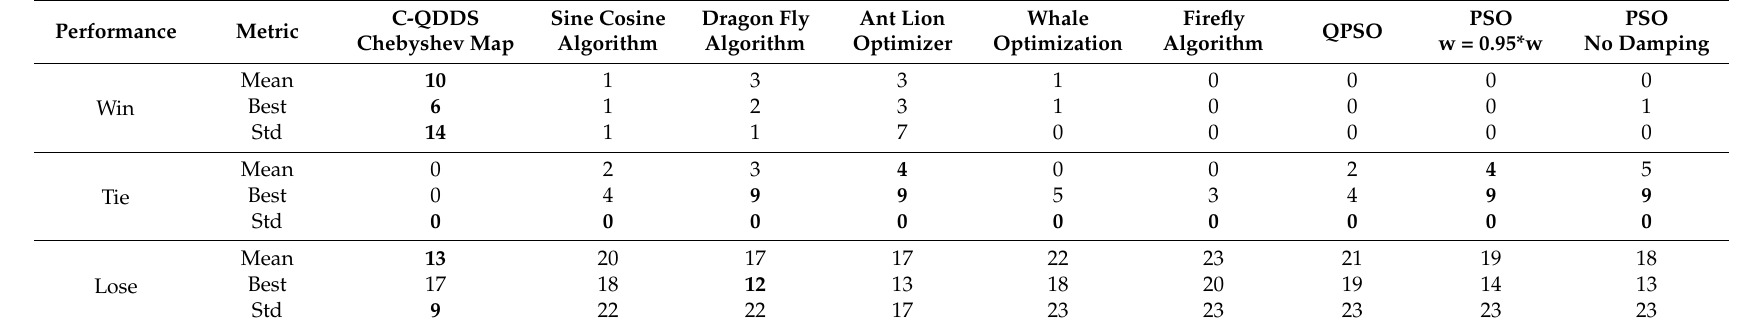
Table 13. Win/tie/loss count among competitors w.r.t. reported global best.